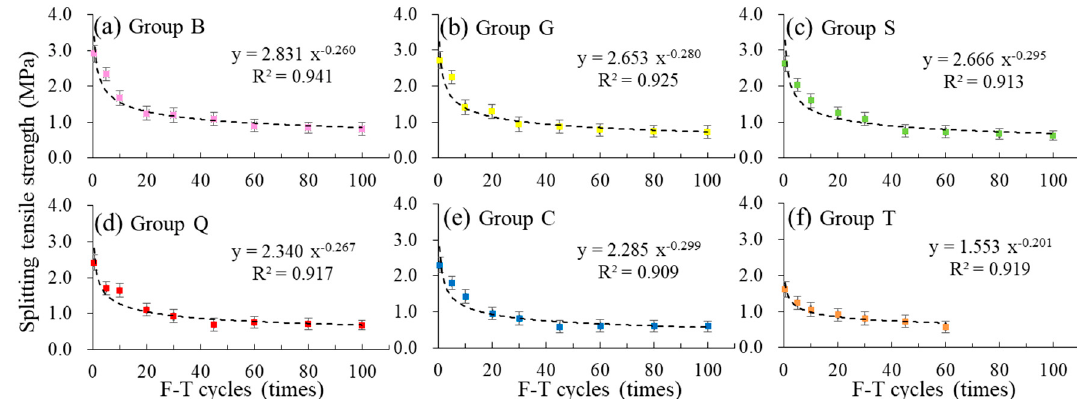
Figure 11. The relationship between splitting tensile strength and the times of F-T cycles: ( a ) Group B, ( b ) Group G, ( c ) Group S, ( d ) Group Q, ( e ) Group C, ( f ) Group T.